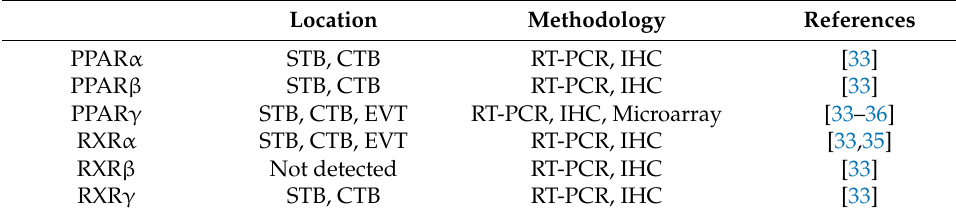
Figure 2. The path of human trophoblast differentiation. Trophoblast stem cells are derived from the trophectoderm. The cytotrophoblasts differentiate in two ways: invasive extravillous trophoblast (EVT) and syncytiotrophoblast (STB). EVT can be divided into two subtypes, one of which invades deeply into the uterine wall as groups of cells, termed interstitial EVT, and the other invades the maternal decidual arterioles as endovascular EVT. Table 2. Expression of PPARs and RXRs in human trophoblasts.